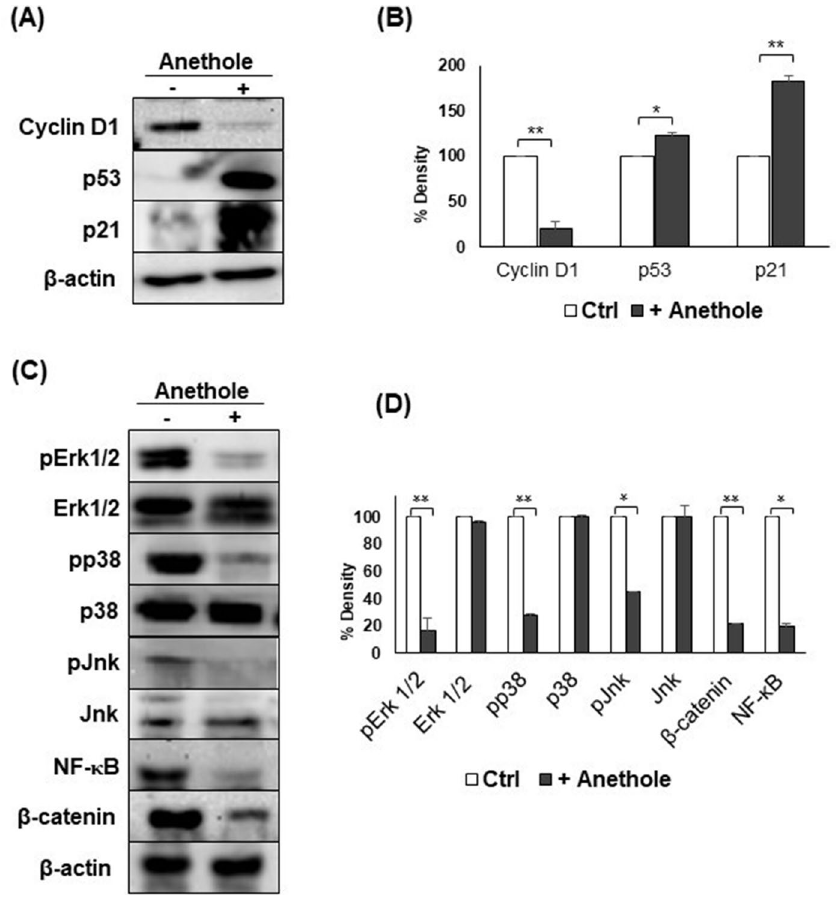
Figure 6. Anethole modulates the expression of several genes in oral cancer cells. Western blotting confirmed the involvement of anethole (10 μM) on mouth epidermoid carcinoma cells (Ca9-22) after being exposed for 24 h. Proteins were extracted with the Bradford technique before migration on SDS-PAGE (7 to 15%). ( A ) Anethole decreases oncogenic proteins and increases the expression of the tumor suppressor gene and the cell cycle inhibitor (n = 3). ( B ) Histogram displaying the three experiments of the cell cycle with western blotting reporting results as the means (% of density) ± SD. ( C ) Anethole inhibits the proliferative pathways MAPKinase (ERK 1/2, p38, and Jnk), Wnt (β-catenin) and NF-κB (n = 3). ( D ) Histogram showing the three experiments of signaling pathways with western blotting reporting results as the means (% of density) ± SD. Significance was obtained when comparing the control to anethole treated cells. * p < 0.05 or ** p <